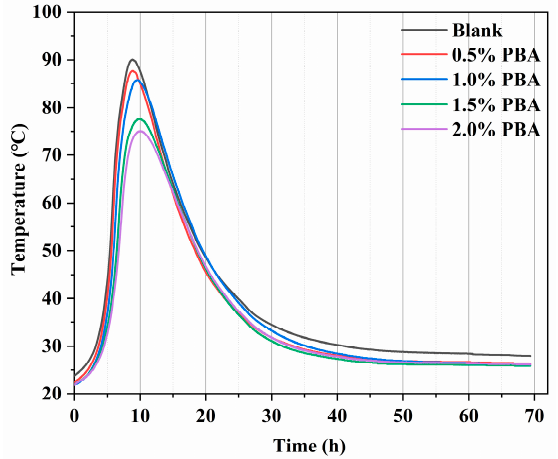
Figure 4. The e ff ect of PBA on the hydration temperature rise of cement. Figure 4. The effect of PBA on the hydration temperature rise of